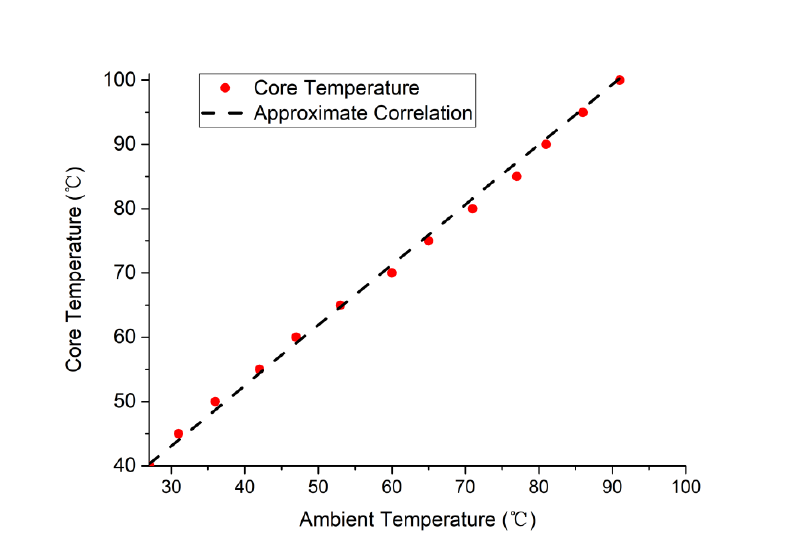
Figure 3. The relationship between the ambient temperature and the core temperature.